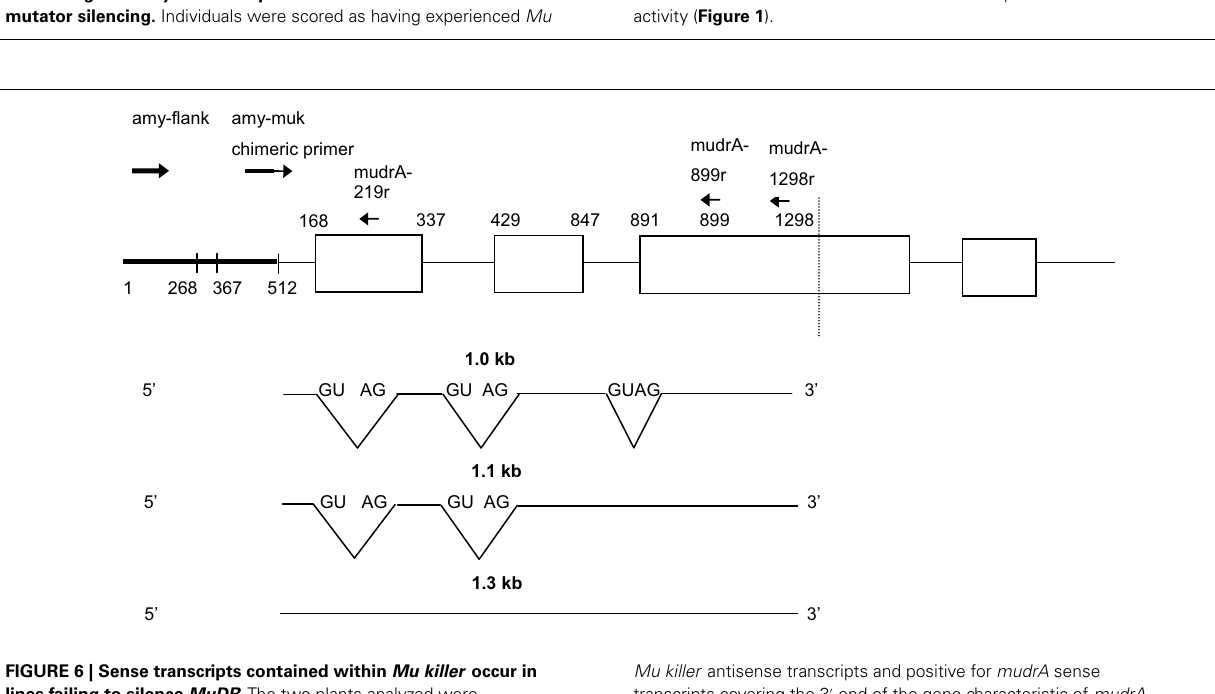
killer -induced silencing based on having genomic DNA positive for Mukiller but cDNA that lacked mudrA 3 (cid:48) transcripts indicative of mutator activity ( Figure 1 ).